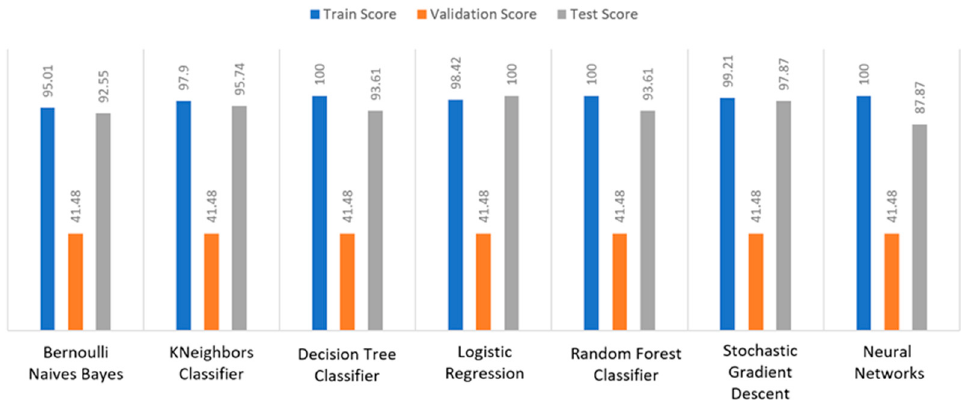
Figure 27. Train–validation–test score for breast cancer use case.